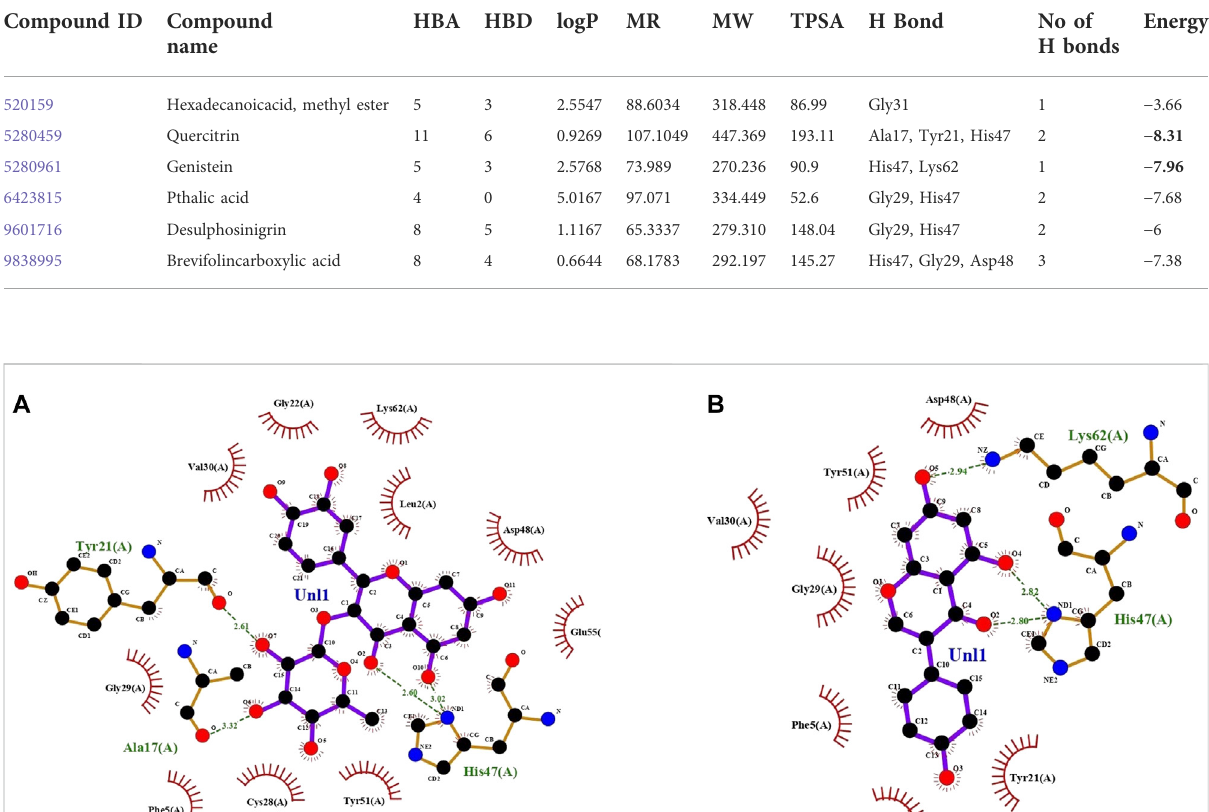
TABLE 1 Molecular docking of selective bioactive molecules and their energy values against sPLA 2 IIa (1POE) by Auto Dock Tools 4.2. HBA: hydrogen bond acceptor; HBD: hydrogen bond donor; logP: lipophilicity; MR: molar refractivity; MW: molecular weight in daltons; TPSA: topological polar surface area in Å.